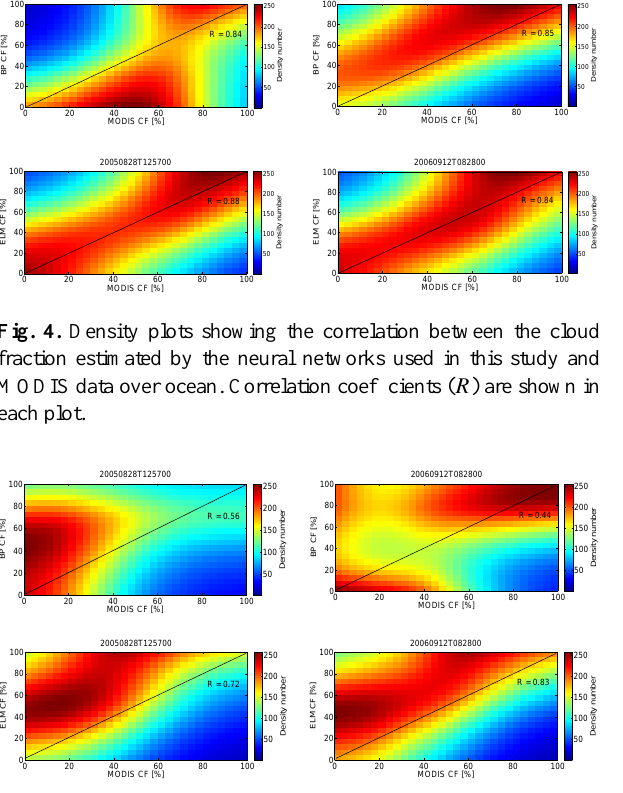
Fig. 5. Density plots showing the correlation between the cloud fraction estimated by the neural networks used in this study and MODIS data over land. Correlation coefficients ( R ) are shown in each